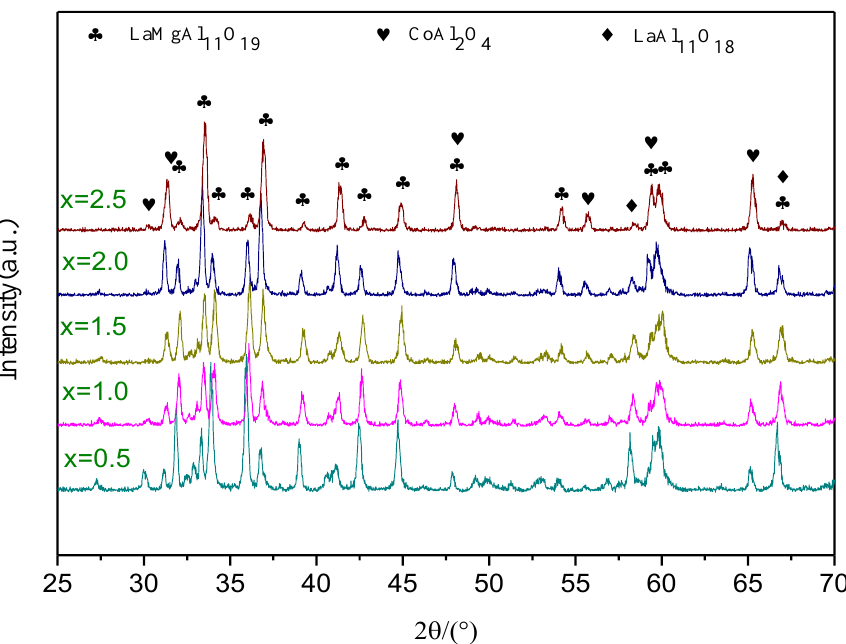
Figure 1. X-ray spectra of different Co contents of Mg-based lanthanum hexaaluminate samples prepared at 1450 °C.